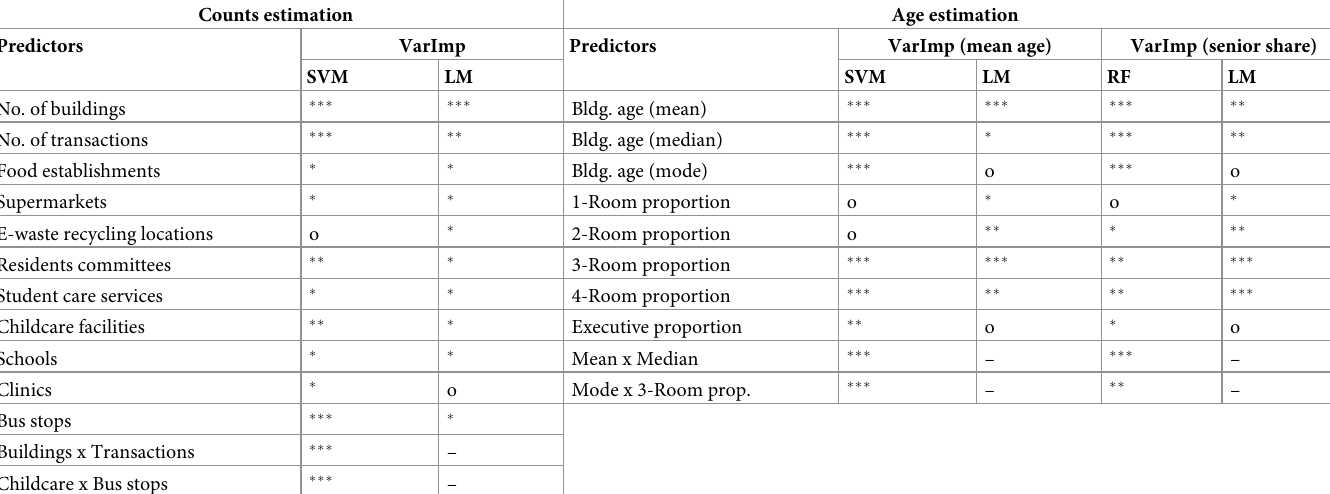
Table 3. An overview of the predictors and their variable importance from none (o) to high ( ��� ). Counts